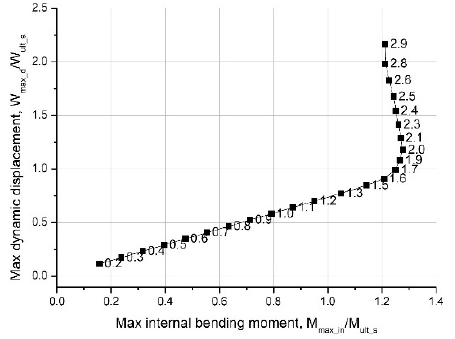
Figure 17. Internal bending moment and vertical displacement for mid-span box girder M4 at load Table 5. Comparison of dynamic ultimate moment for box girder with various plate thickness.